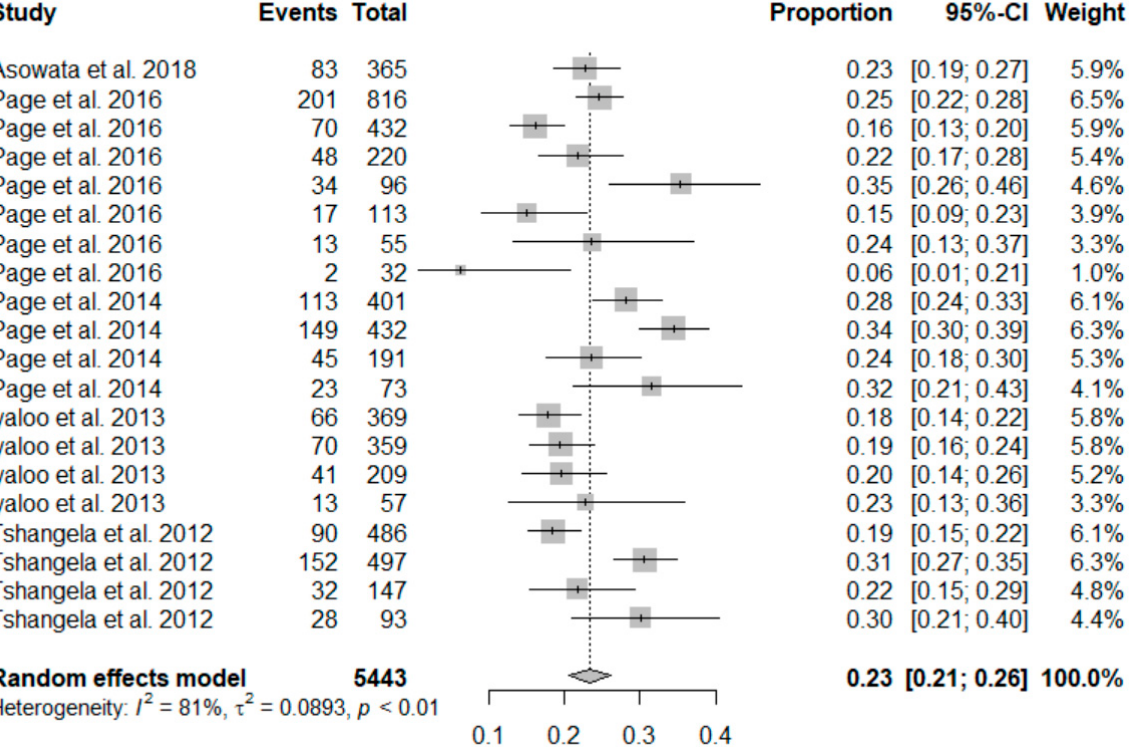
Figure 4. Funnel plot showing the presence of publication bias.